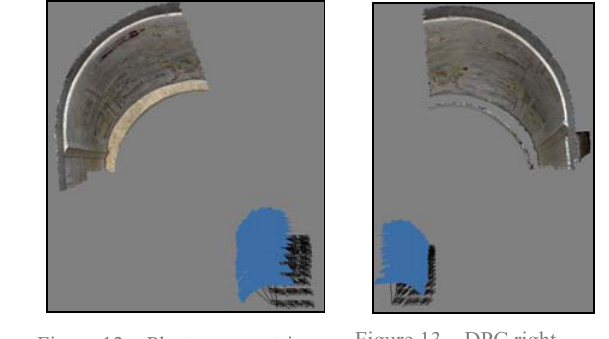
Figure 9 – Unfolded surfaces of the frescoed intrados sectors of Brunelleschis’s Dome in “Basilica di Santa Maria